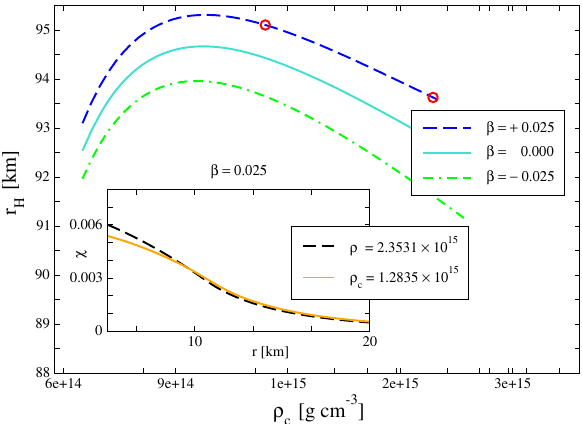
Fig. 10 The radius of gravitational halo r H versus the central density ρ c until the onset of gravitational instability at the radial profiles for the scalarcurvature χ (corresponding tothe points denoted by the open circle in the main graph) falls off faster for a higher density, similar to the Starobinsky case ( β = 0), as shown in the inset of Fig. 2